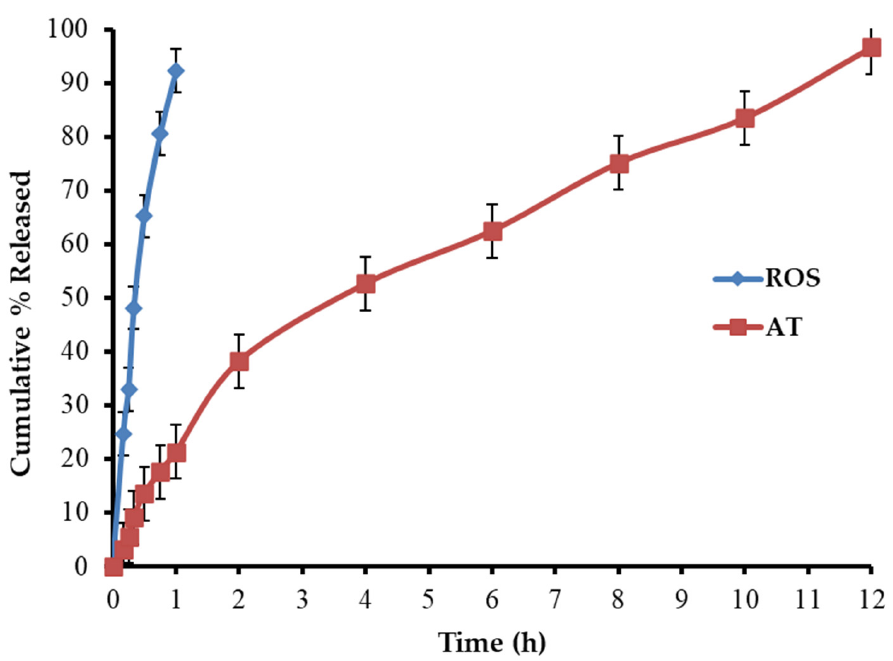
Figure 9. In vitro release profile of ROS and AT from the prepared BLTs (mean ± SD, n = 3).